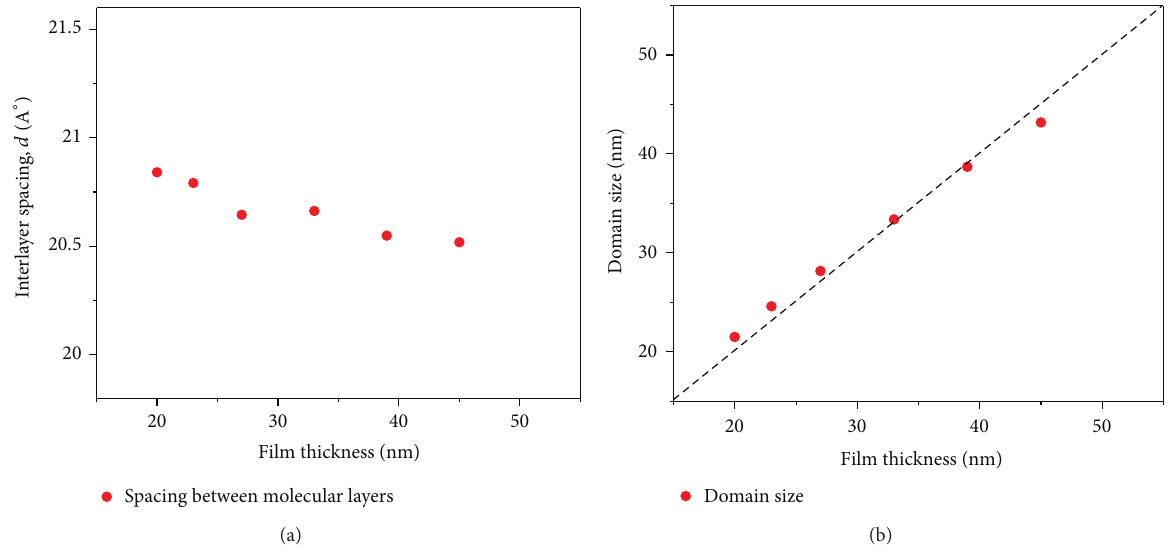
Figure 6: Calculated (a) interlayer spacing and (b) domain size for PTCDI-C8 films with different